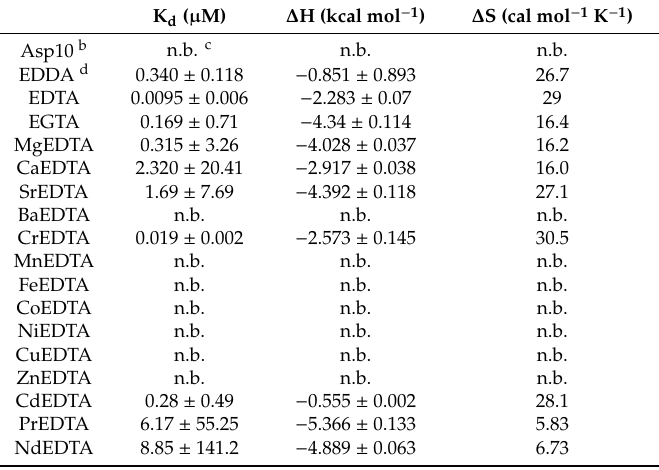
Figure 4. Isothermal titration calorimetry of EppA with various ligands: ( a ) ethylenediamine- N,N ′ - diacetate (EDDA) (blue), ethylenediaminetetraacetate (EDTA) (red), and ethylene glycol-bis( β - aminoethylether)- N,N,N ′ ,N ′ -tetraacetate (EGTA) (black); ( b ) poly-aspartate (decapeptide); ( c ) MgEDTA (black circles), CaEDTA (red triangles), SrEDTA (blue diamonds), and BaEDTA (green squares); ( d ) MgEGTA (black circles), CaEGTA (red triangles), SrEGTA (blue diamonds), and BaEGTA (green squares); ( e ) Co(II)EDTA (green triangles), Mn(II)EDTA (magenta squares), and Fe(III)EDTA (orange circles); ( f ) PrEDTA (green diamond), NdEDTA (purple squares), EuEDTA (red triangles), and TbEDTA (orange circles). Table 1. Thermodynamic parameters determined by isothermal titration calorimetry. a